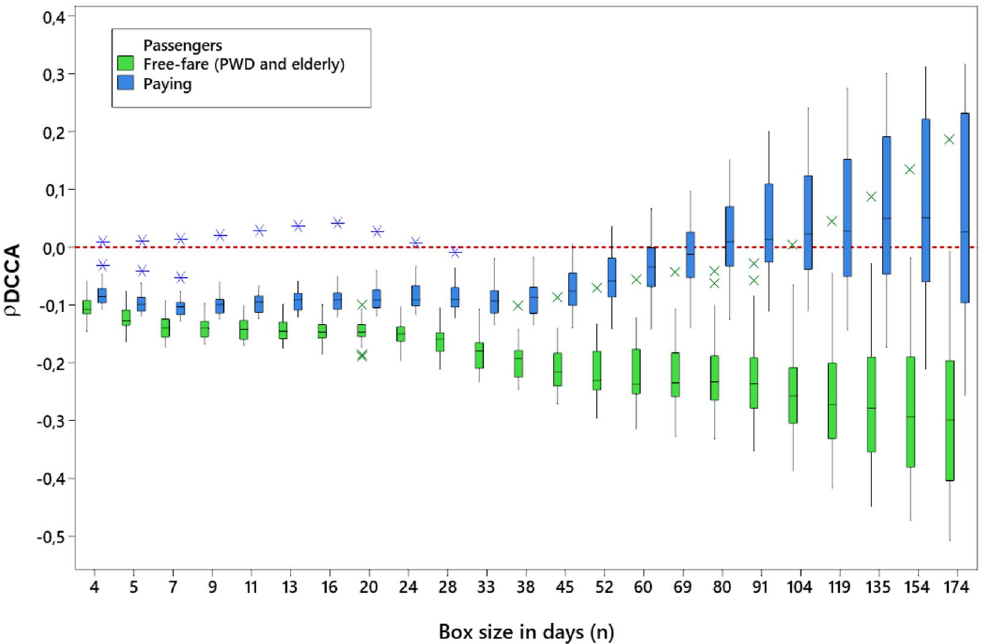
Figure 2. Boxplot with a correlation trend between PWD and elderly passengers (free fare) × other passengers (paying).